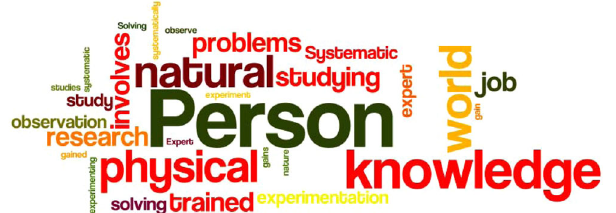
FIG. 1. Wordle created from student definitions of science and scientists, from their first short